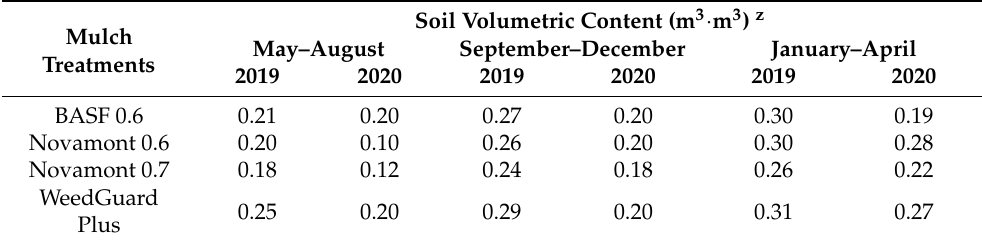
Table 3. Average soil moisture from May to April 2019/2020 and 2020/2021 at the experimental site in northwestern Washington, USA.